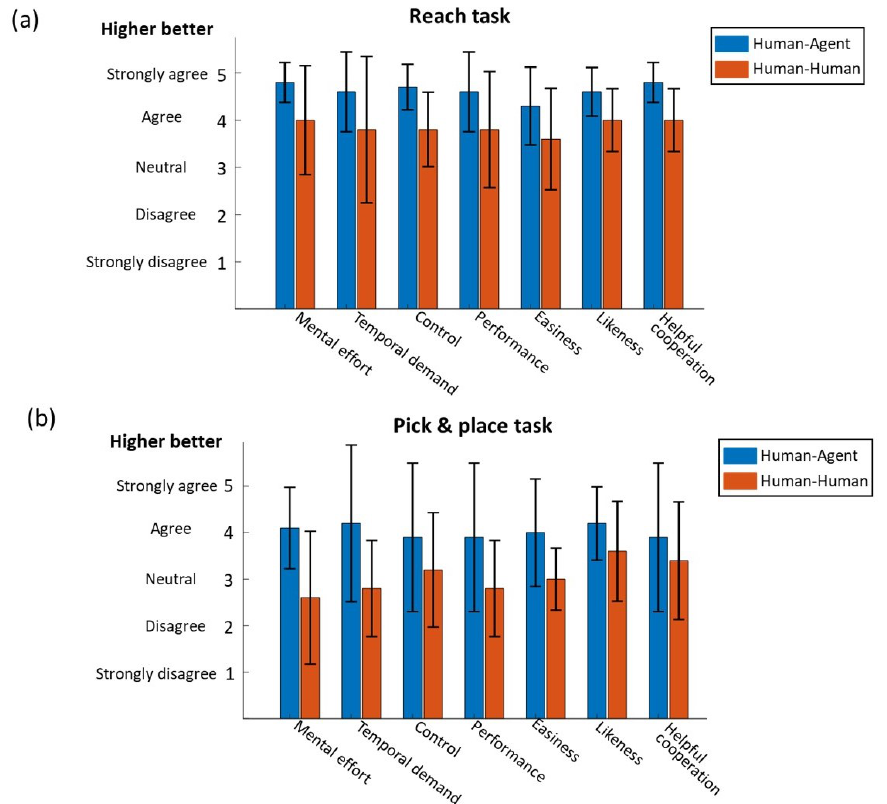
Figure 11. Questionnaire result for ( a ) reach task and ( b ) pick & place